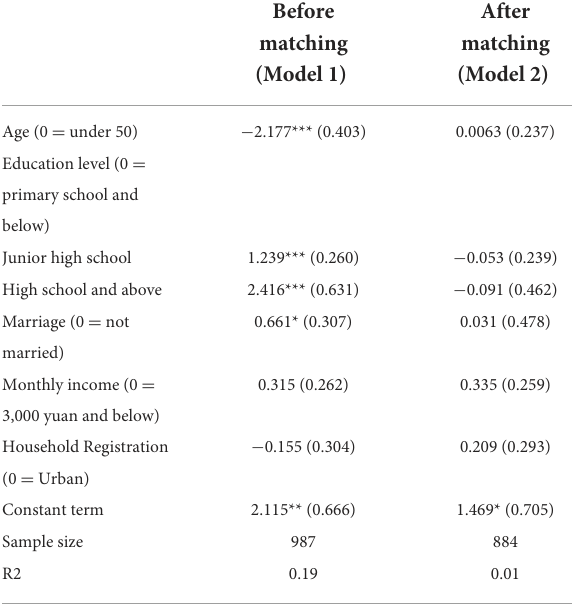
TABLE 2 Covariable balance results of WeChat /QQ usage before and after